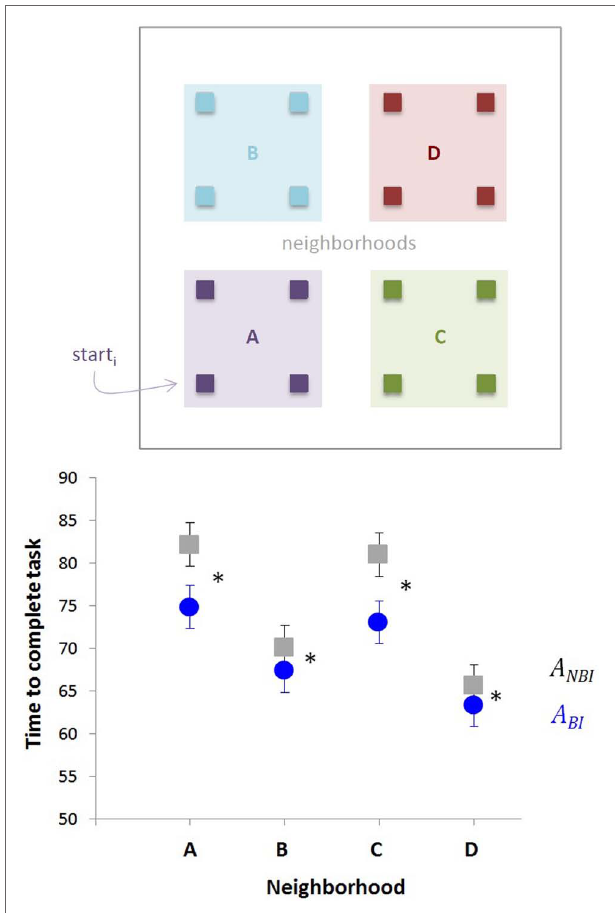
FIGURE 8 | Belief–intention (BI) learning improves navigation . Agents started from one of 16 different positions, as indicated by the small squares on the map (top). For purposes of analysis, four neighborhoods were defined. The time for each agent to reach the target was measured (bottom). Agents that undergo BI learning navigate significantly faster to the target than agents without learning (ANOVA, significant main effects of agent type and neighborhood p < 0.05, with asterisk indicating the difference between agents). Neighborhoods are the same as in Figure 9 .